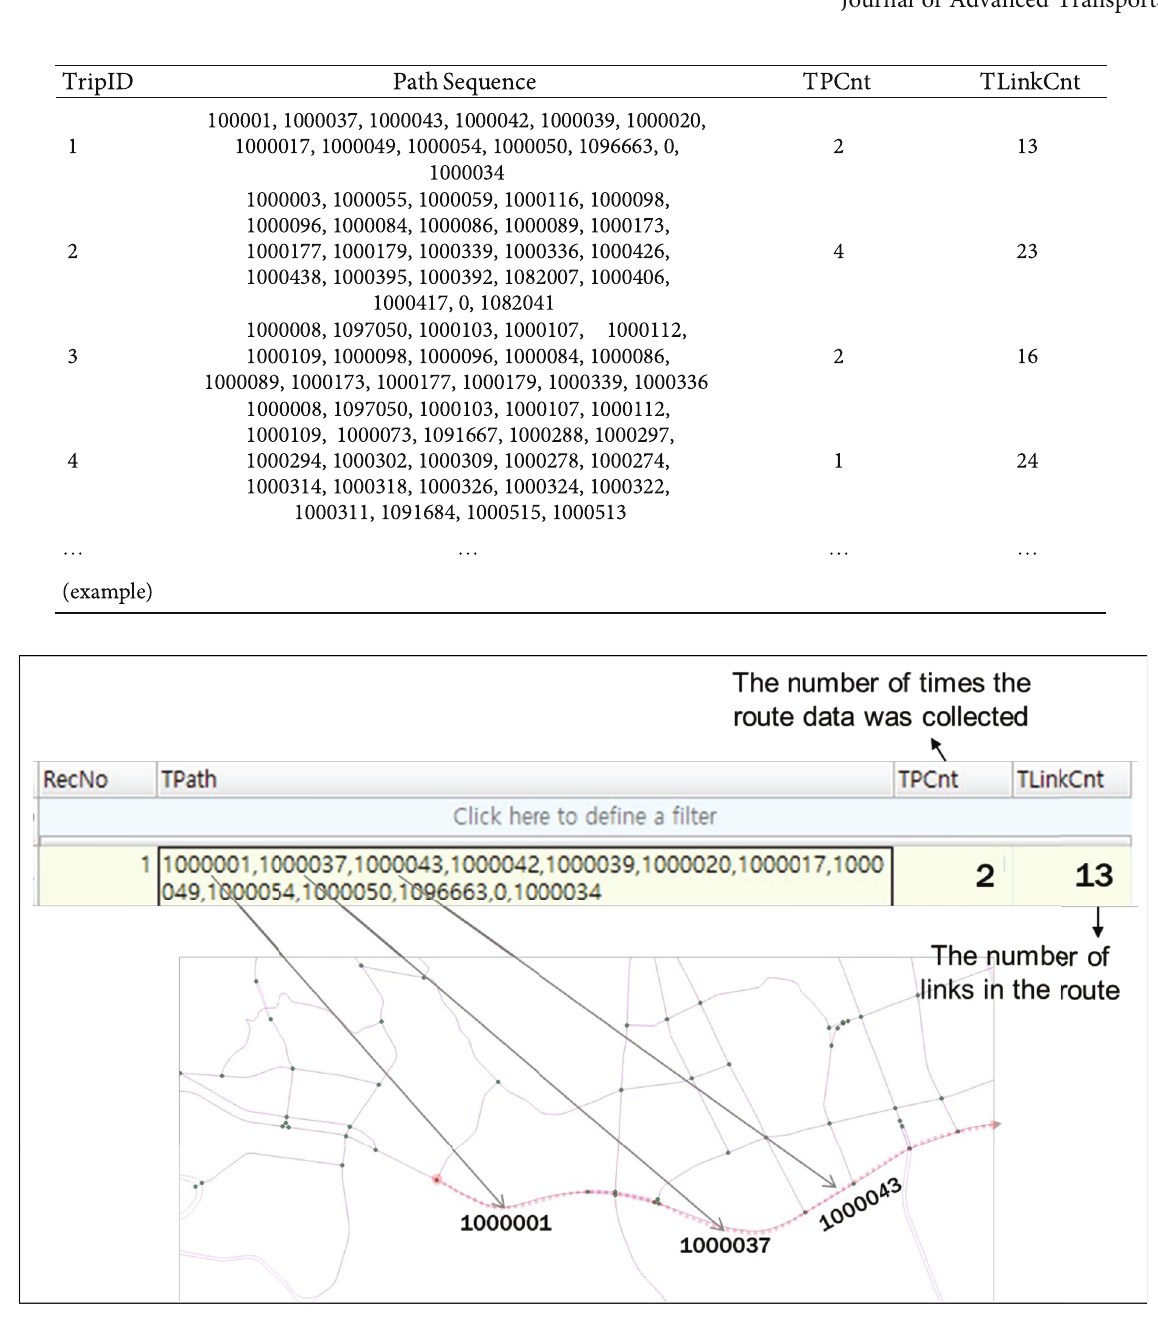
Figure 3: Data scheme of individual trajectory data (View-T